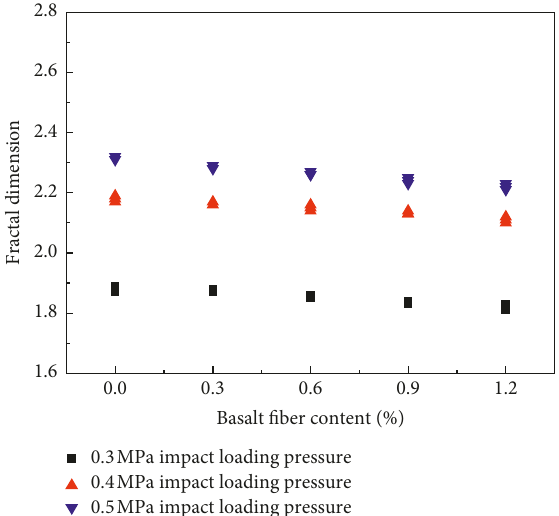
Figure 19: Relationship between fractal dimension and basalt fiber content.